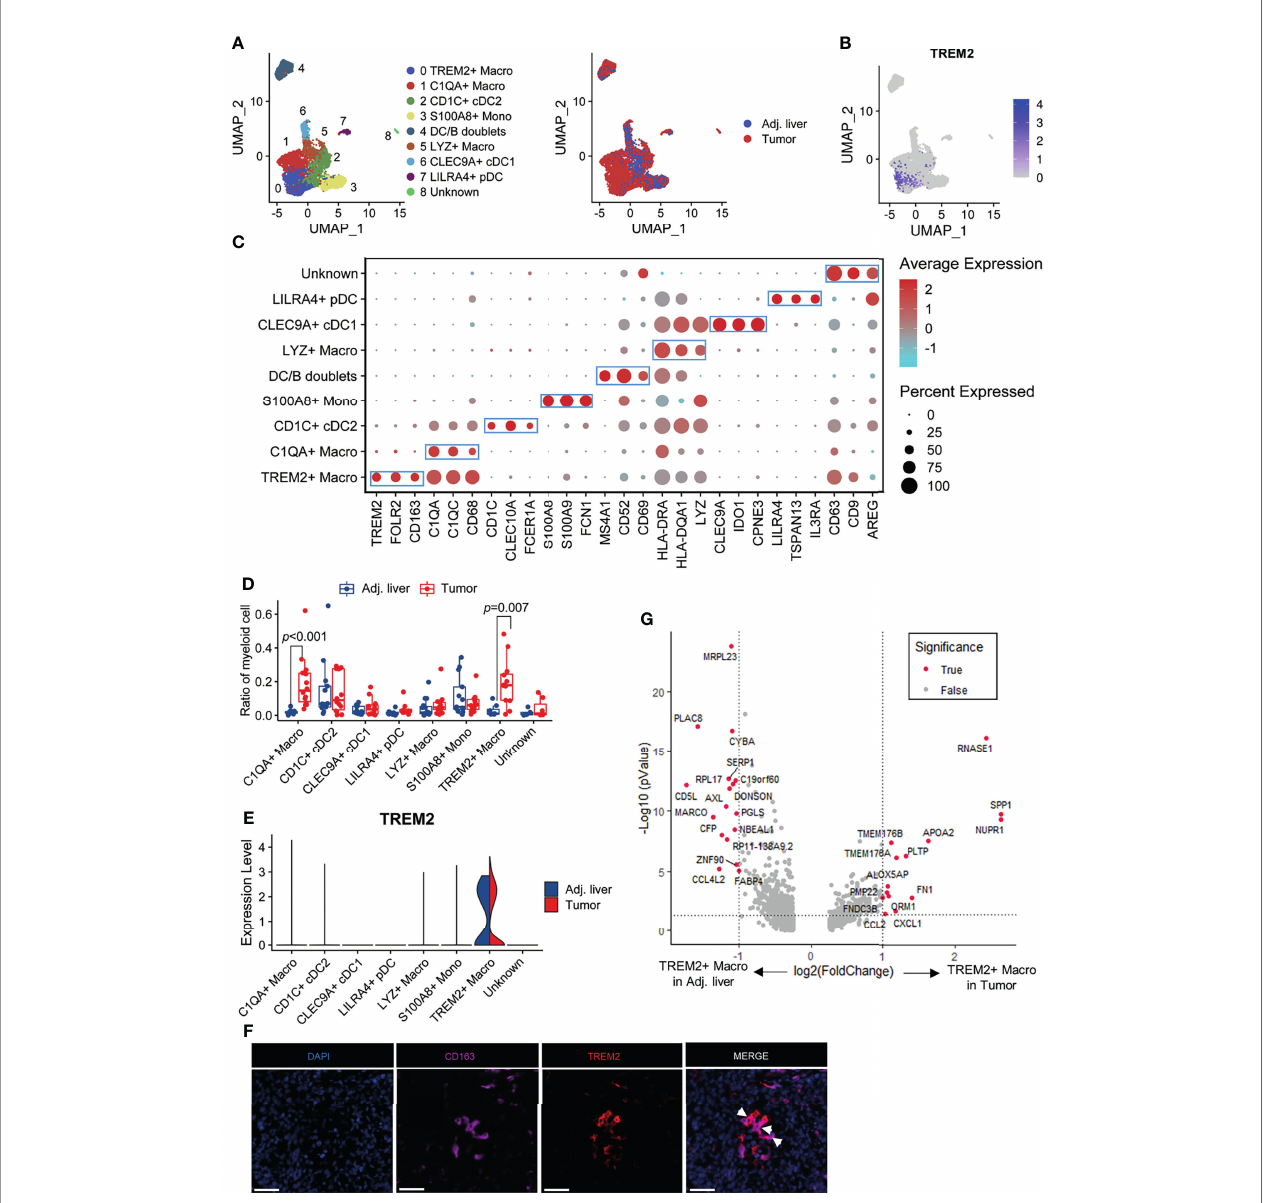
FIGURE 2 | TREM2 expression de fi nes a tumor-in fi ltrating myeloid subpopulation. (A) UMAP projection showing the subtypes of myeloid cells colored by cluster (left) and tissue origin (right). (B) UMAP plot of myeloid cells colored by TREM2 expression level. (C) Bubble heatmap depicting the expression of marker genes in the indicated subtypes of myeloid cells. The dot size indicates the fraction of expressing cells, and the dots are colored based on average expression levels. (D) Box plot representing the fraction of myeloid subgroups in tumor and adjacent liver tissues. Signi fi cance was determined by unpaired Wilcoxon test. (E) Violin plot showing the expression level of TREM2 in myeloid subgroups derived from tumor and adjacent liver tissues. (F) Representative images of immuno fl uorescence staining of TREM2 and CD163 in HCC tissues, showing the in fi ltration of TREM2 + CD163 + macrophages. The scale bar represents 50 m m. (G) Volcano plot showing differentially expressed genes between TREM2 + macrophages derived from tumor samples and those derived from adjacent liver tissues. Signi fi cance was determined by Benjamini-Hochberg adjusted two-sided Wilcoxon